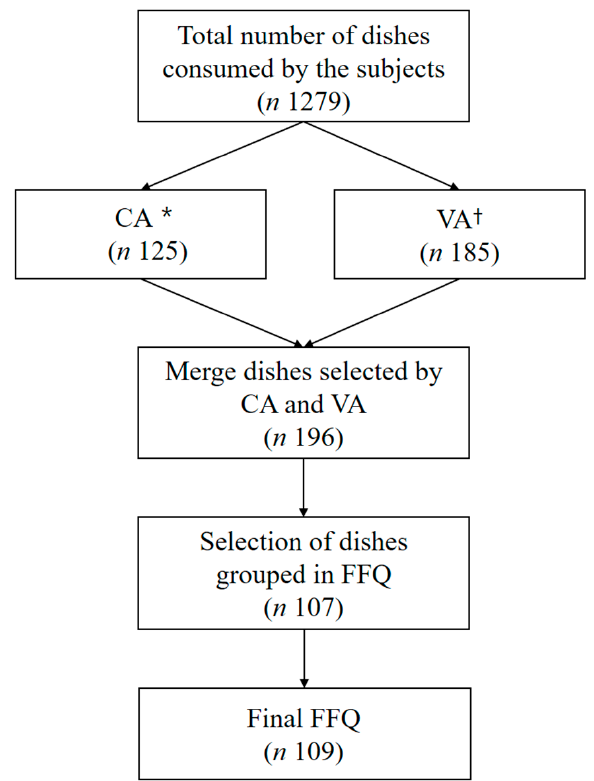
Figure 1. Steps used to develop a list of 109 dishes from the 1279 dishes consumed by the participants. * Contribution analysis (CA) is a statistical method to identify the contribution of dishes to dietary factors. † Variability analysis (VA) is a statistical method to identify inter-individual variability of the dishes to dietary